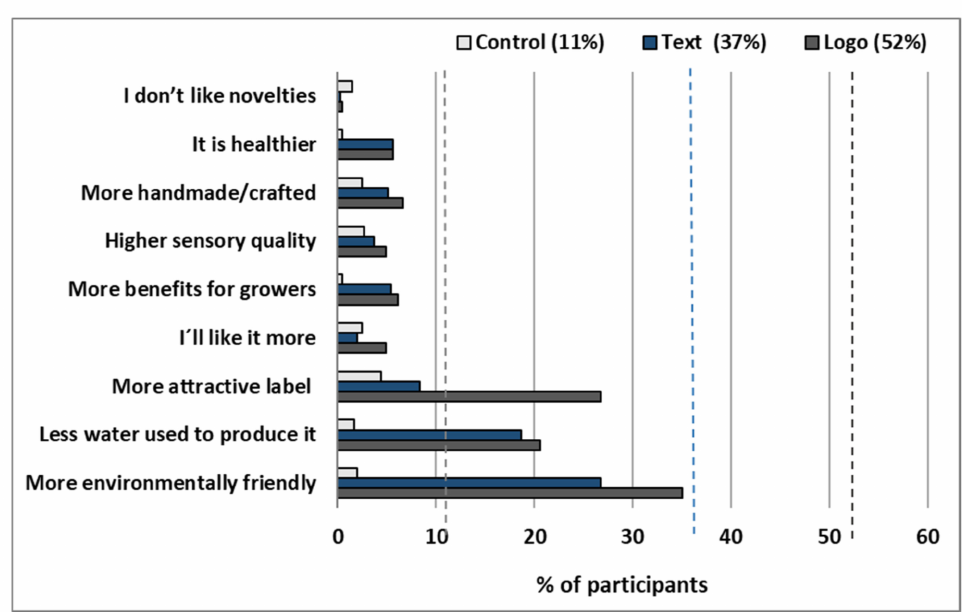
Figure 5. Percentage of all the consumers (408) who selected the different reasons for choice according to their label choice. The percentages in brackets in the legend indicate the percentage of consumers who chose each specific label (control, text, logo). The colored and dotted bars in the graph also represent these percentages.